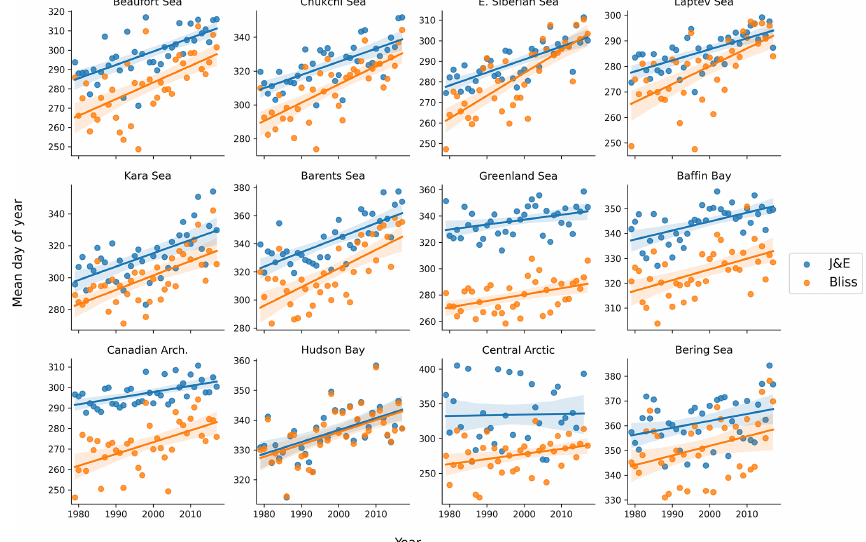
Figure 7. Yearly values of J&E’s freeze-up end date (blue symbols) and the Bliss et al. (2019) day of closing (orange symbols) in the various MASIE regions. Corresponding trend lines are shown in each panel. The y -axis labels represent day of the year. Date scales on the y axis vary among panels in order to optimize the display of data points. Numerical values of slopes and their significance levels are provided in Table